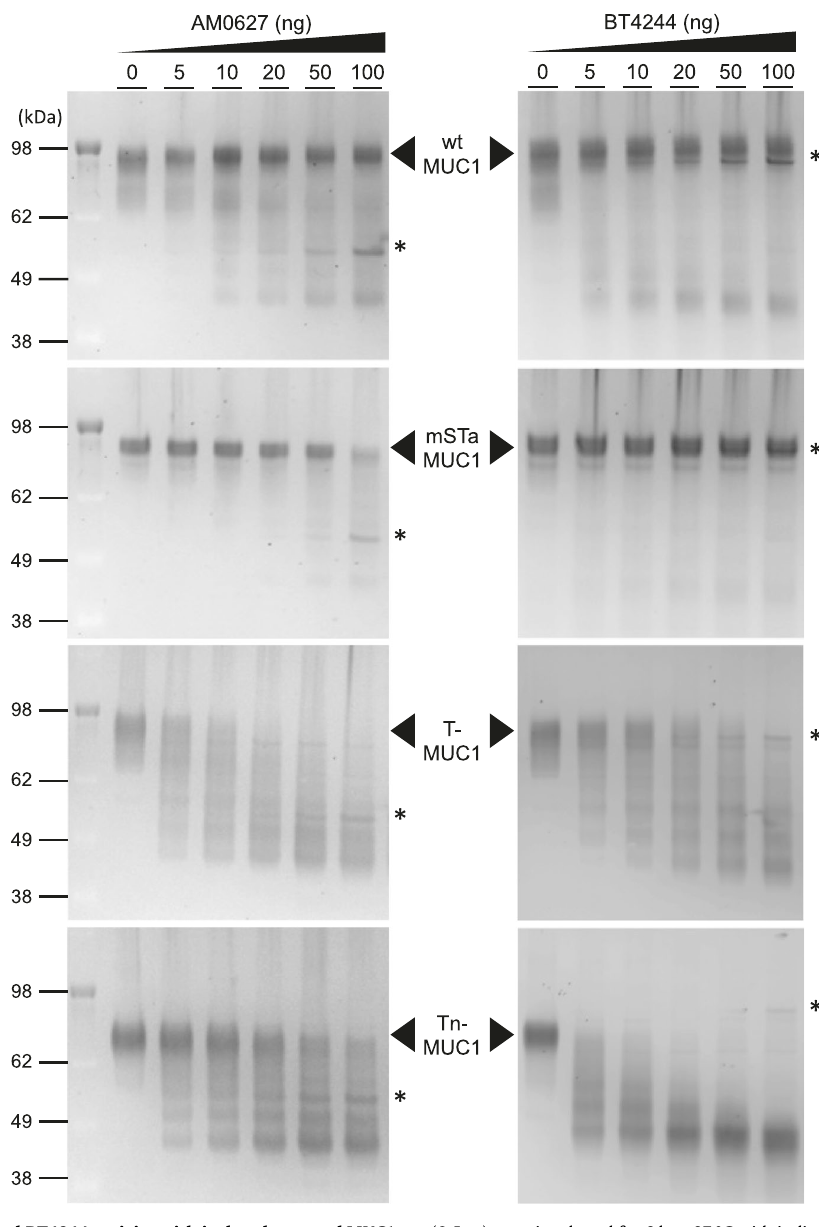
(0.5 µ g) were incubated for 3h at 37°C with indicated enzyme and gels visualized with Krypton fl uorescent protein stain. * indicates the bands corresponding to wt AM0627 A21-E506 and BT4244. The experiments were performed in